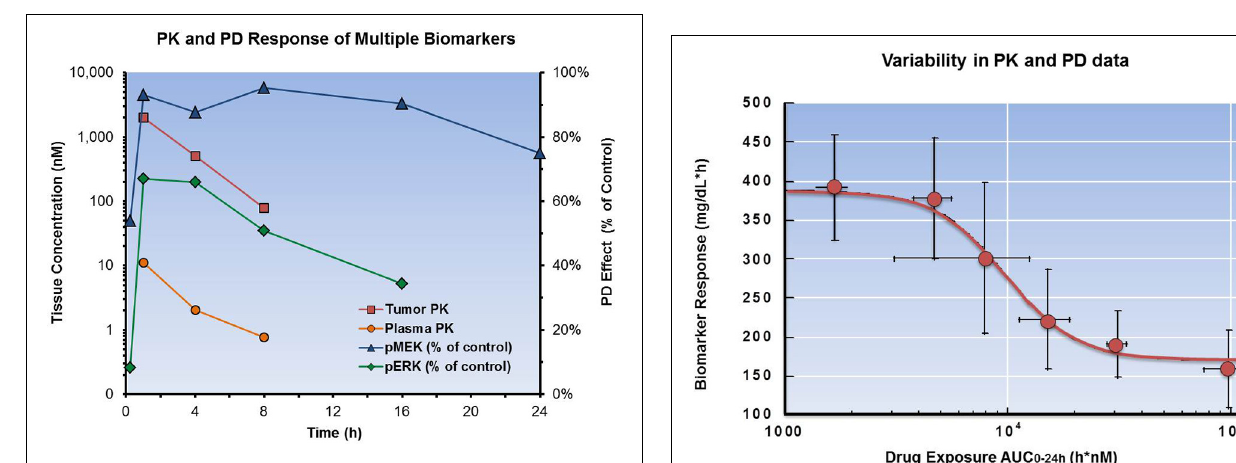
FIGURE 12 | Variability in PK and PD data. Dose-dependent suppression of biomarker response in rats following administration of a drug candidate. The error bars represent variability in both plasma AUC and biomarker